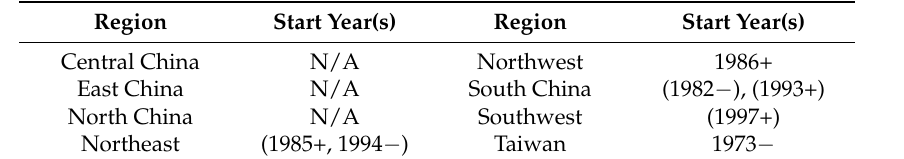
Table 3. Approximate year of the beginning of an upward or downward trend according to sequential version of Mann-Kendall rank statistic for eight regions in China from 1961 to 2014. N/A means no significant trend at the 95% level of significance; + denotes an upward trend; − denotes a downward trend; parentheses indicate the approximate year of a new change in trend which was not statistically significant.